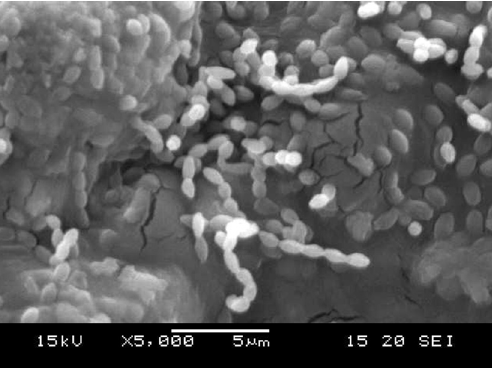
Fig. 3. Electron micrograph image of isolate SKCMM1